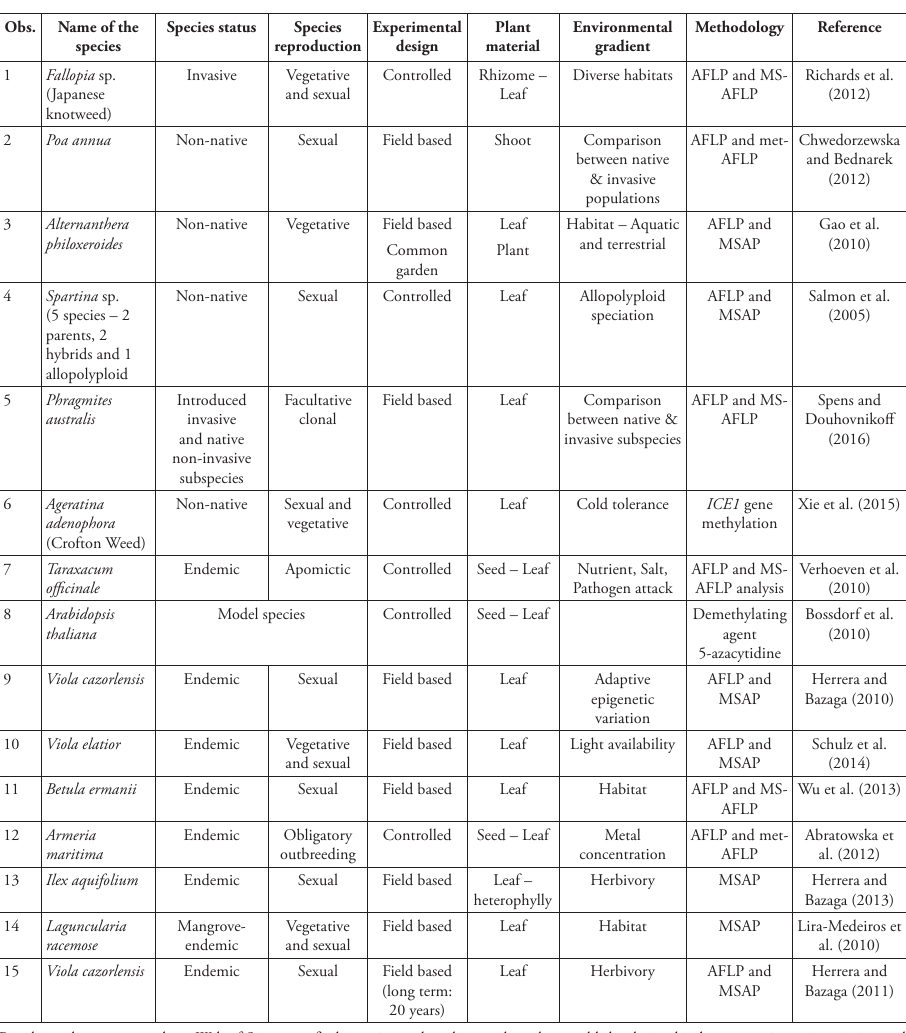
Table 1. Examples of experimental studies investigating the role of epigenetic variation in phenotypic plasticity in both non-native and native, model and non-model species in controlled as well as field-based experiments. The factors which may influence the experimental designing and outcomes are mentioned here: species reproduction (sexual, vegetative, or both), plant material used, environmental gradient re- sponsible for epigenetically controlled plastic changes and genetic as well as methylation sensitive genetic marker-based analysis (AFLP = Amplified Fragment Length Polymorphism; MS-AFLP/MSAP/met-AFLP = methylation sensitive